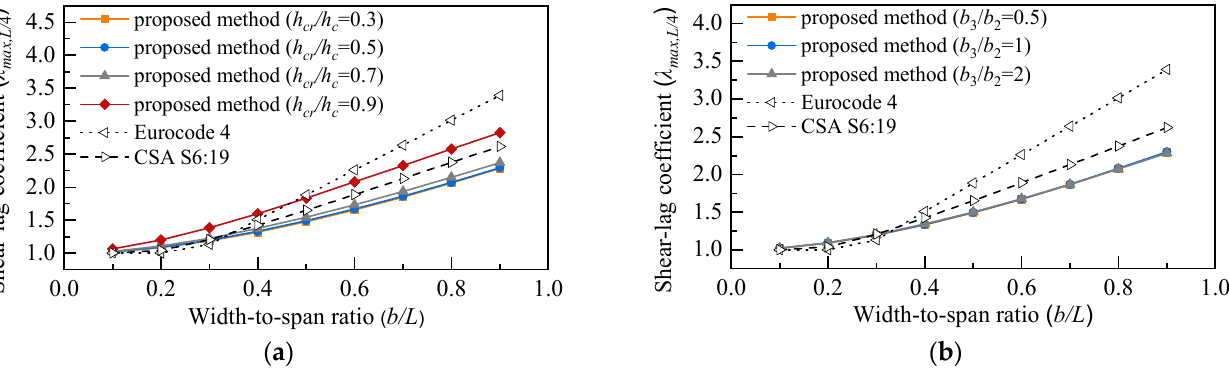
Figure 19. Relation curve of b/L and λ max,L/ 4 in different calculation method: ( a ) different h cr /h c ( b ) different b 3 /b 2